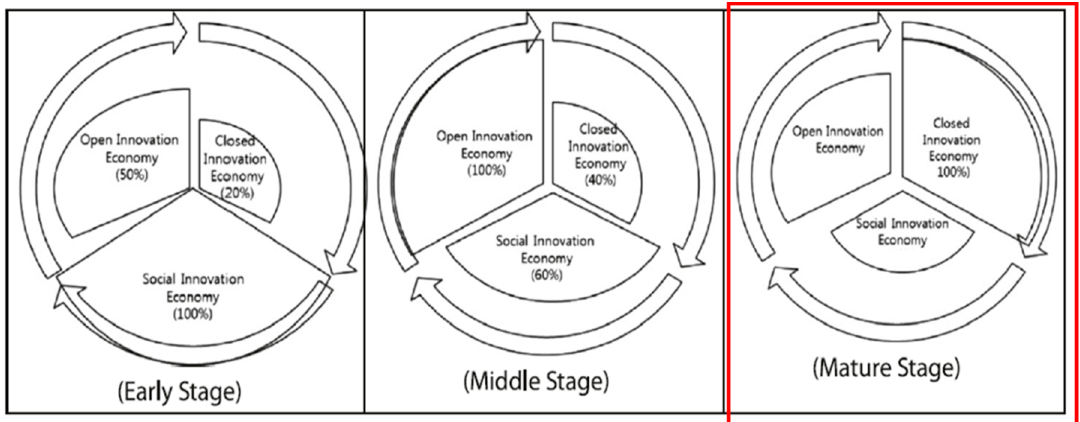
Figure 2. Life cycle of dynamics of open innovation. Source; modified from [17], Figure 6).